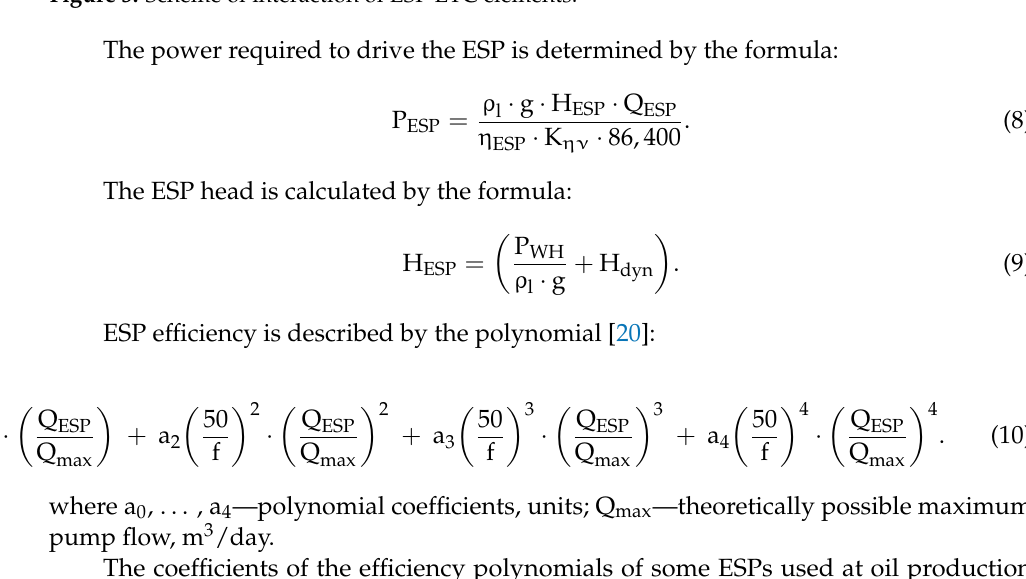
Figure 3. Scheme of interaction of ESP ETC elements.